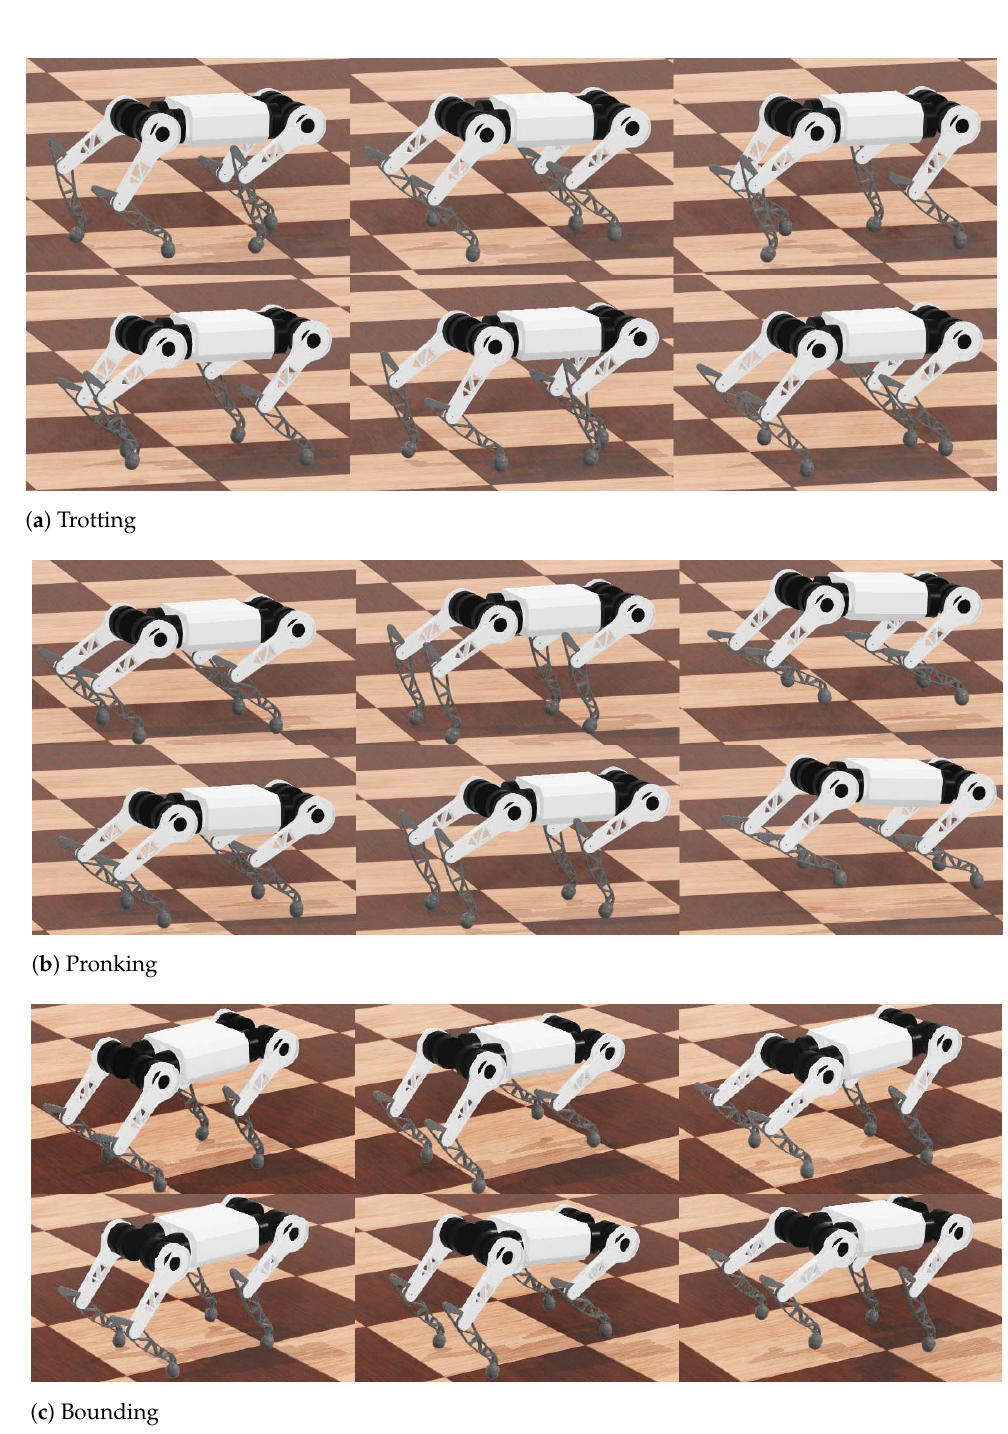
Figure 14. Various dynamic gaits of PADWQ in a simulated